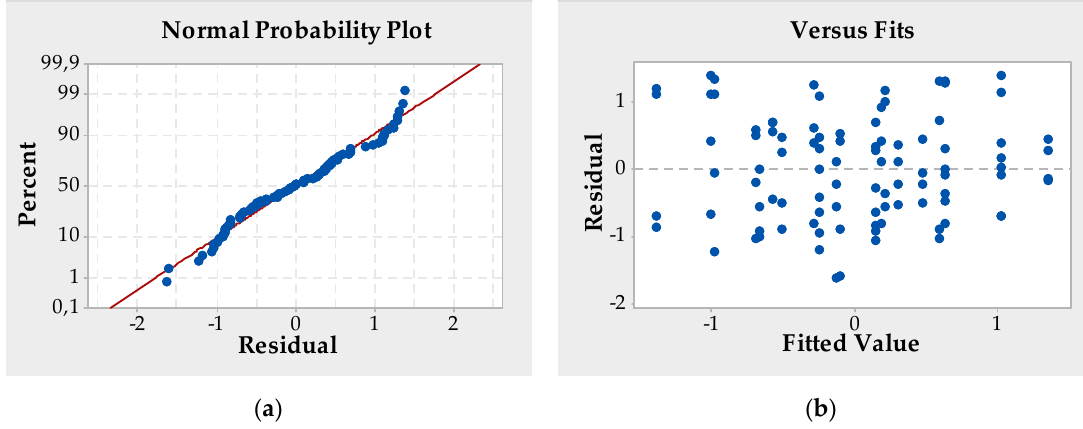
Figure 10. ( a ) Probability plot and ( b ) residuals versus predicted values for the model.